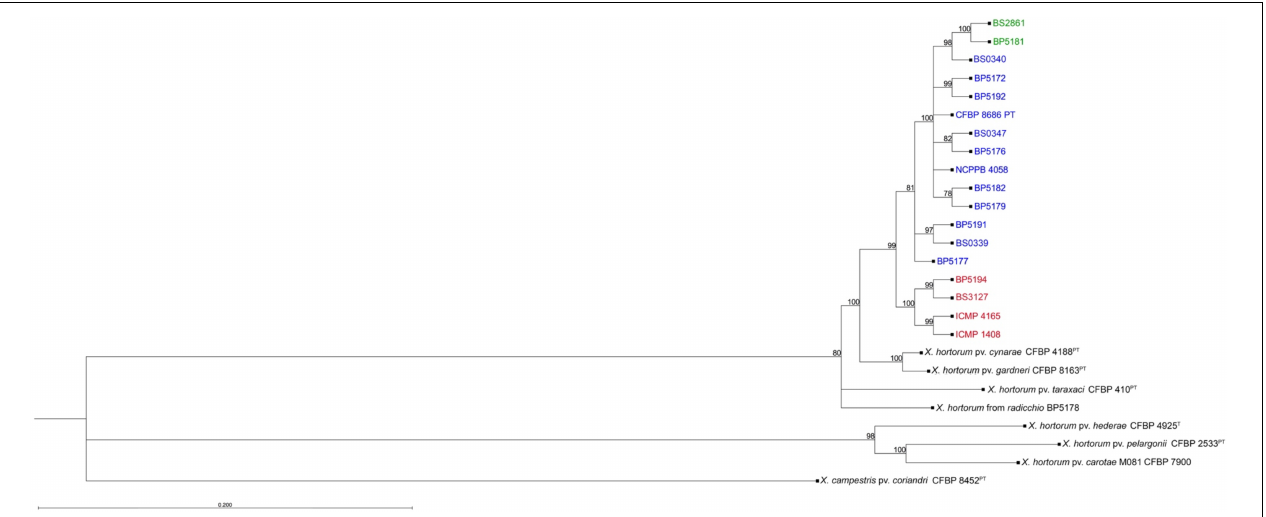
FIGURE 3 | Phylogenetic tree constructed from whole genome SNP data. Maximum-likelihood phylogeny of Xanthomonas hortorum pv. vitians strains of race 1 (blue), race 2 (red), and race 3 (green) and related Xanthomonas type and pathotype strains (black) used in this study. SNP data was extracted from trimmed Illumina sequence reads and core aligned using the snippy-multi pipeline (Seemann, 2015) and the tree was built from sequence alignment using CLC Genomics Workbench. This phylogeny was constructed using the neighbor-joining clustering method and the general time-reversible substitution method with rate variation (4 categories) and estimated topology. Bootstrap values are shown above branches and branch length represents the expected number of nucleotide substitutions per site. Branches shorter than 0.0100 are shown as having a length of